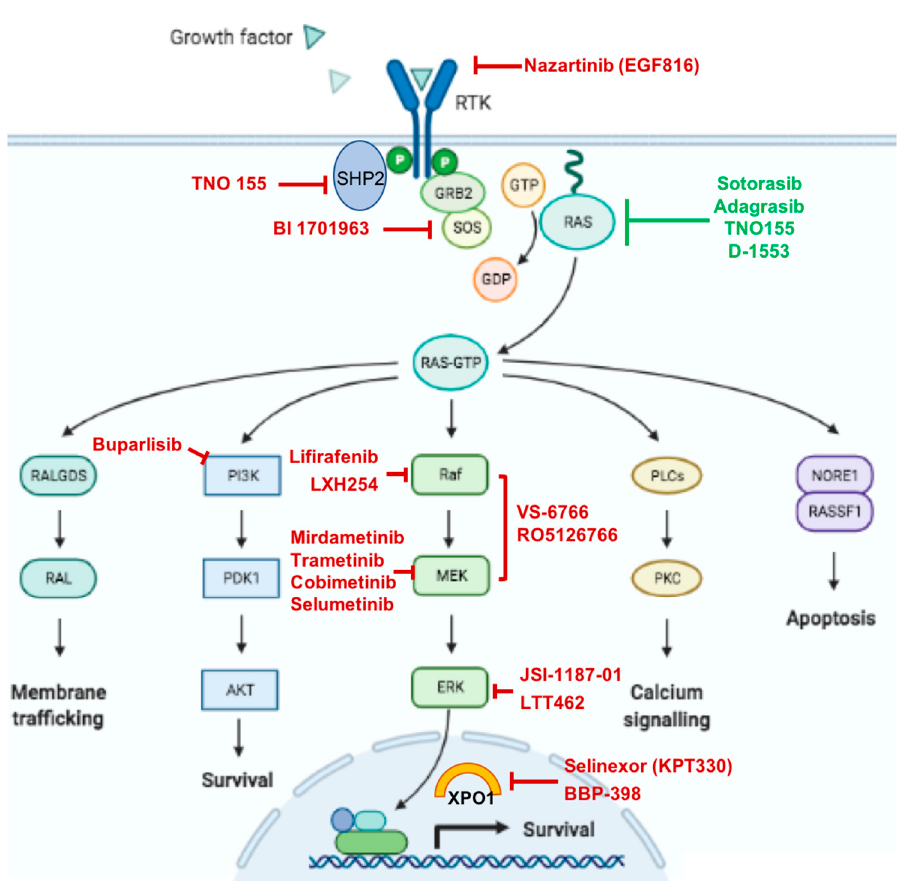
Figure 1. Major effector intracellular pathways activated by KRAS and an overview of the most important therapeutic compounds currently under development; the green color indicates selec- tive KRAS G12C inhibitors.